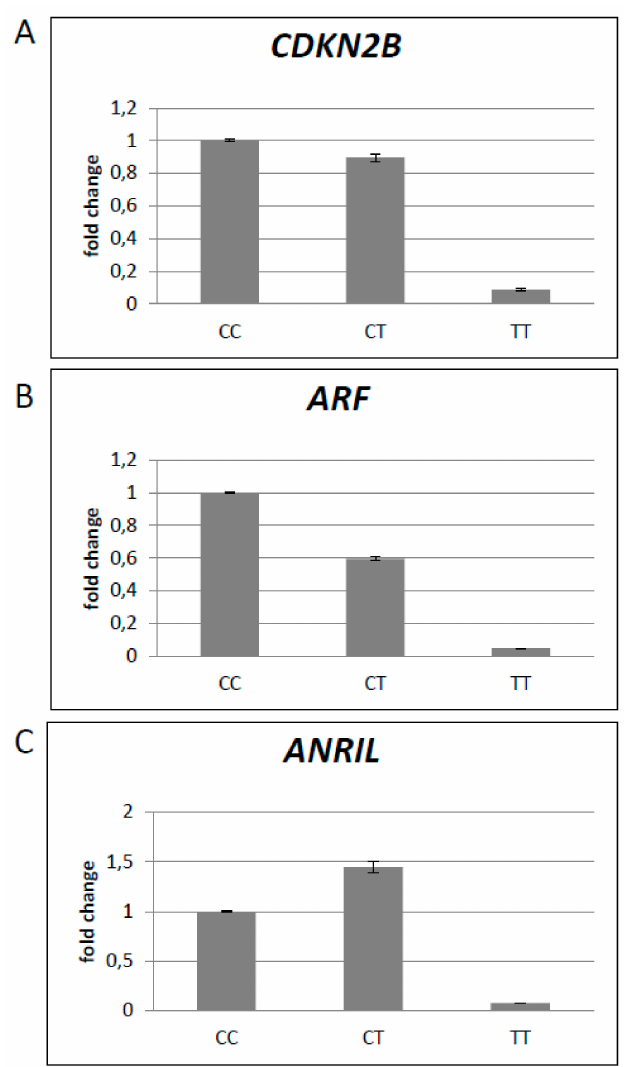
Figure 3. Average of the expression of CDKN2B , ARF , and ANRIL the PBMCs of patients who had developed an optic pathway glioma (OPG). For each gene, patients were clustered by rs2151280 genotype: DNF ( a ), PNF ( b ), OPG ( c